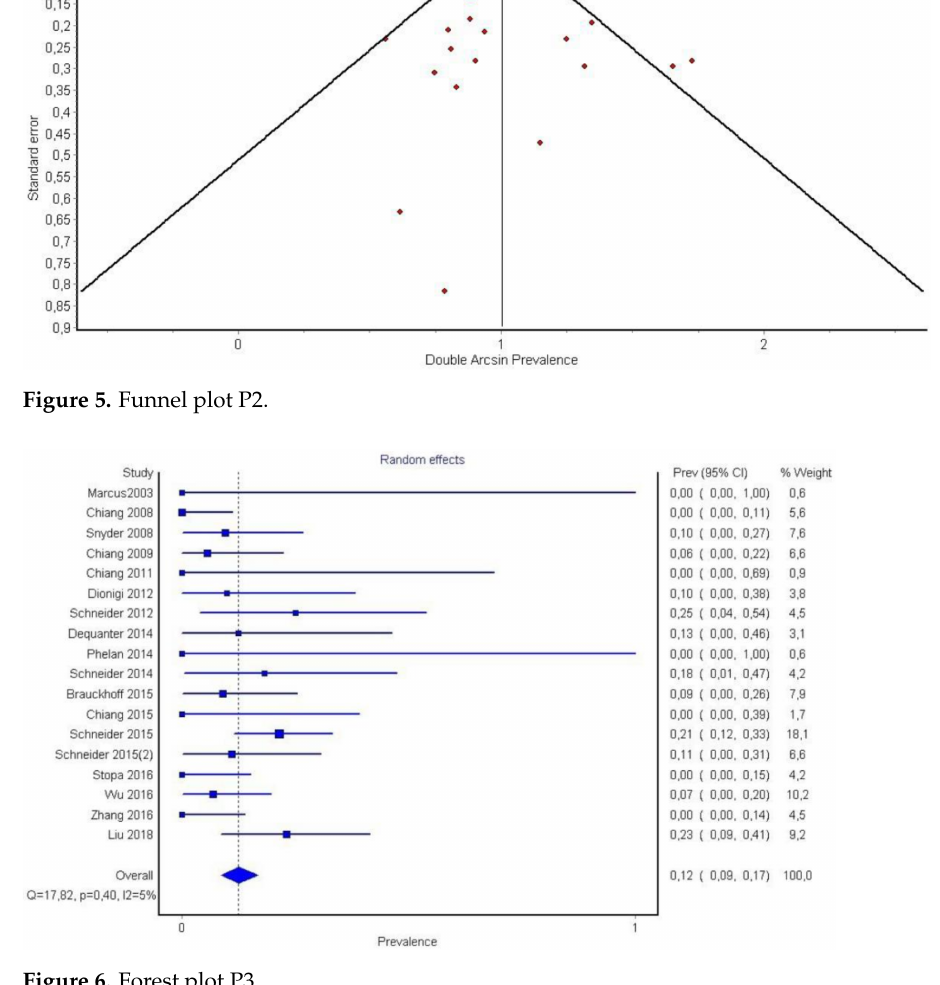
Figure 6. Forest plot P3.